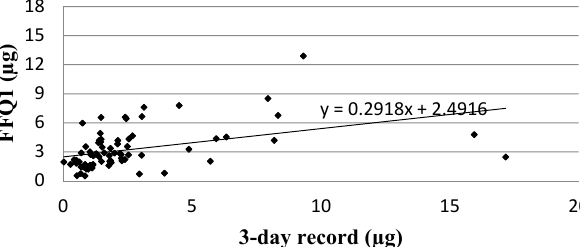
Figure 1. Analysis of correlation between VIDEO-FFQ1 and the three-day dietary record for Vitamin D daily intake (Spearman rank correlation coefficient; p < 0.01, R = 0.5402). FFQ1—VIDEO-FFQ filled out immediately after conducting the three-day dietary record.